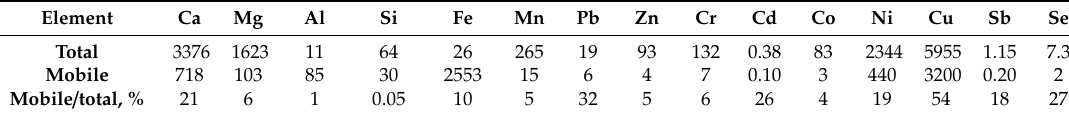
Table 2. The total and mobile content of elements in peat soil, ppm.